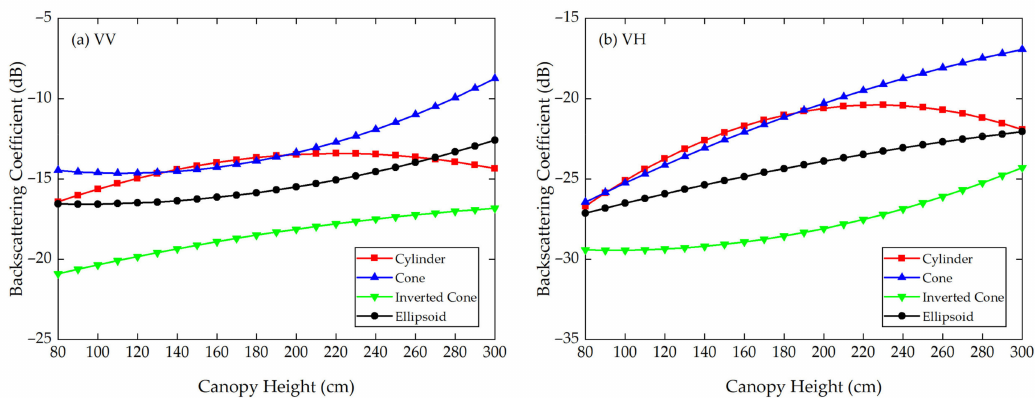
Figure 18. The averaged FEKO simulation results of the backscattering coefficients for different crown shapes at VV and VH polarizations of C band (5.3 GHz) when using canopy A’s parameters as inputs. ( a ) VV polarization; ( b ) VH